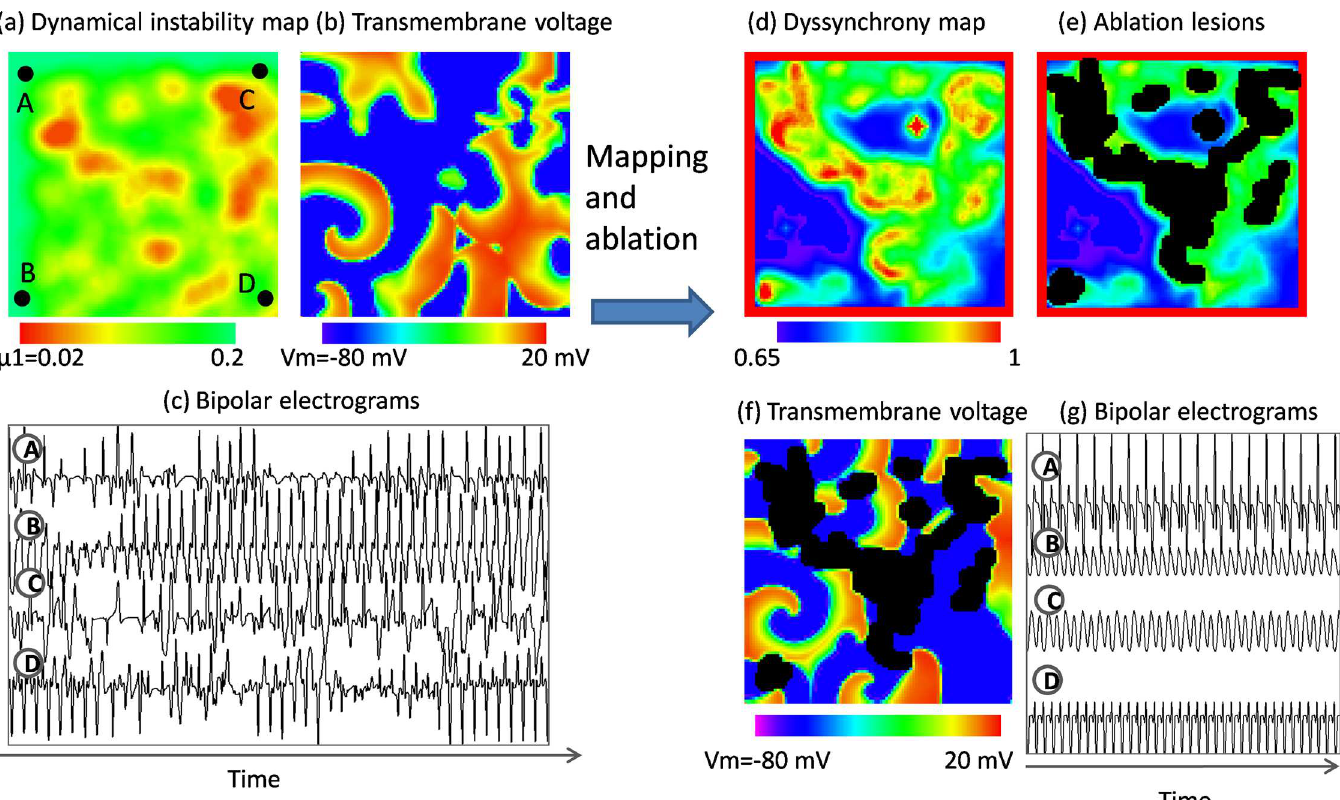
Fig 3. Electrical dyssynchrony in the mathematical model. (a) A mathematical model of AF based on the presence of regions of dynamical instability leadingto wave break (red regions). (b) Map of transmembrane voltage showingindividualwaves in red. (c) Bipolar electrograms measured at corners of the plaquedemonstrating irregularity of morphology and temporal sequenceof activations. (d) Dyssynchrony map reconstructed after simulation for 40 cycles. (e) Regions of high dyssynchrony (in red) became a target of virtual ablation (black regions). (f) The result of virtual ablation on the propagation pattern. (g) Ablation resulted in regularization as evidencedby electrical activity measuredat corners of the plaque.